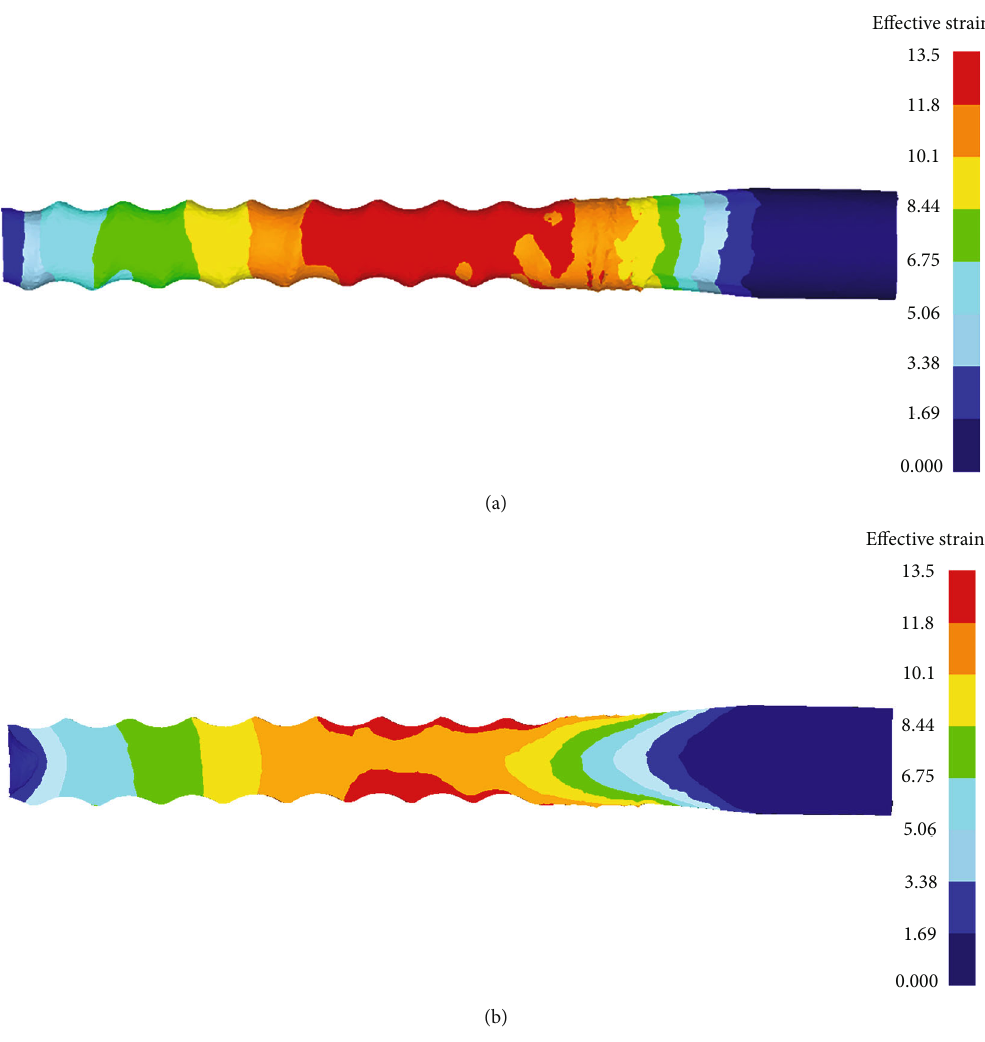
Figure 6: Distribution of e ff ective strain on the surface (a) and in the center of the billet (b).